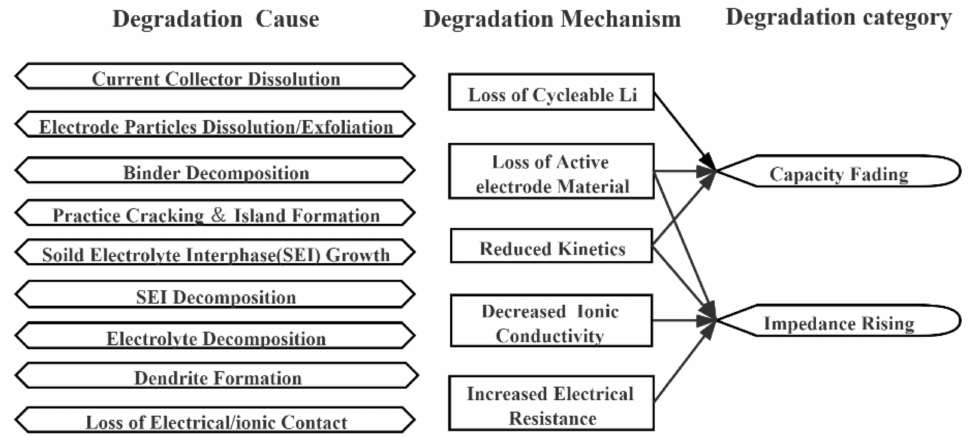
Figure 1. Summary of causes of battery